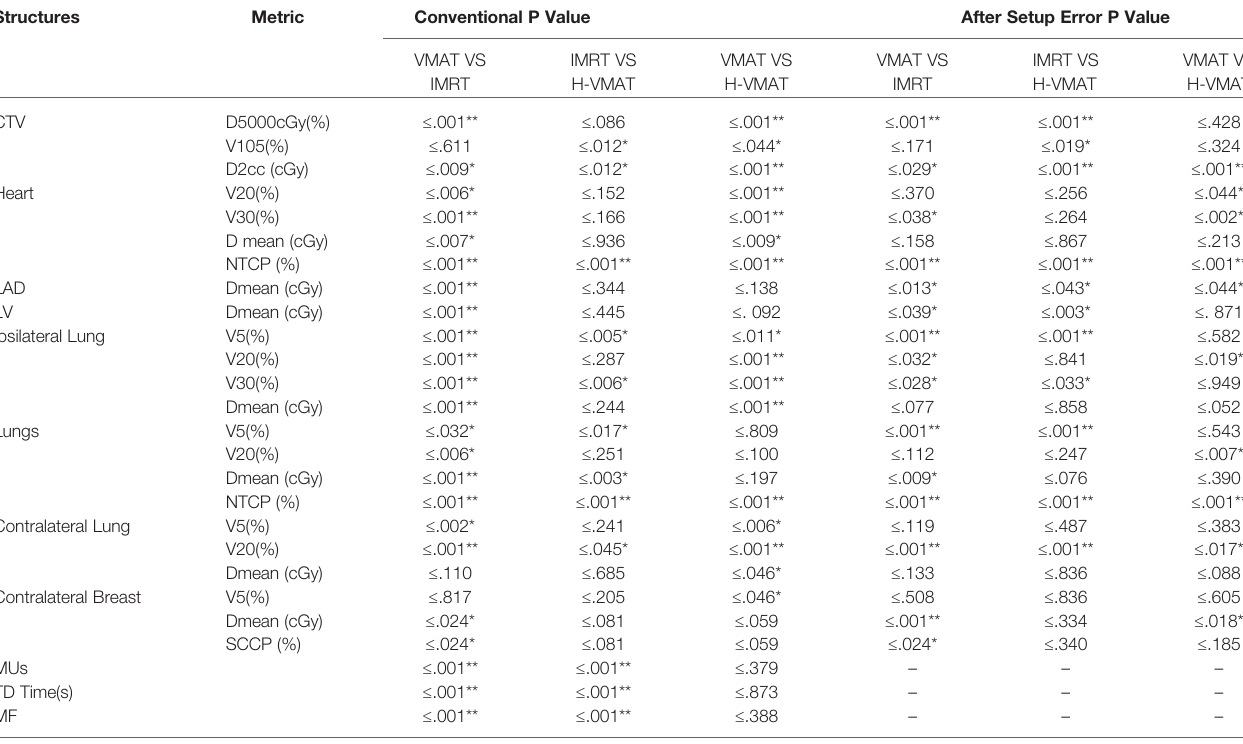
TABLE 4 | P values for three techniques comparison using Wilcoxon signed-rank test. Structures